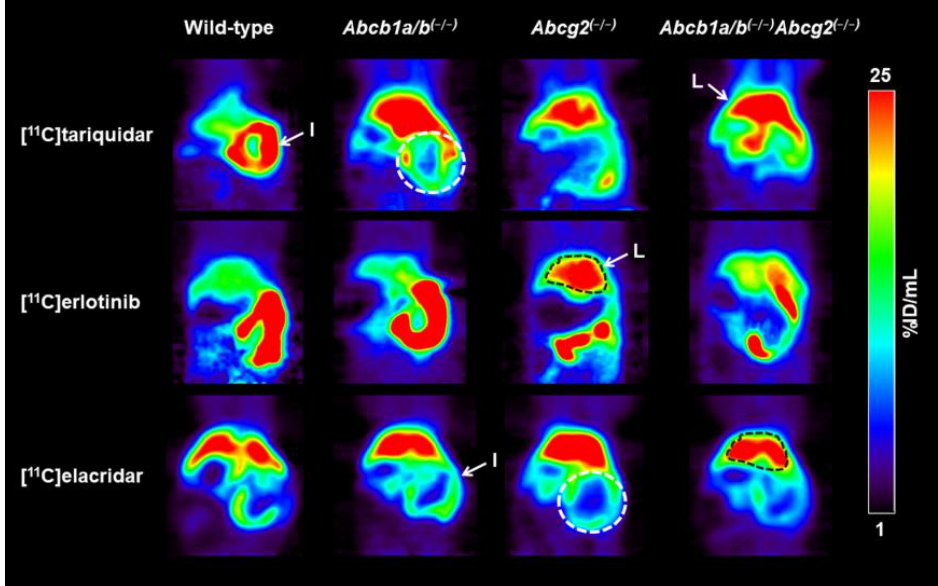
Figure 4. Coronal PET summation images (0–60 min) of the abdominal region obtained after i.v. injection of either [ 11 C]tariquidar, [ 11 C]erlotinib, or [ 11 C]elacridar in one representative wild-type, Abcb1a/b (-/-) , Abcg2 (-/-) , and Abcb1a/b (-/-) Abcg2 (-/-) mouse. Radioactivity concentration is expressed as percent of injected dose per milliliter (%ID/mL). Anatomical structures are labeled with white arrows and colored dashed-line areas (I: intestine, white; L: liver, black). The PK model (Figure 1) was used to estimate the hepatic uptake clearance (CL 1 ) Table 2. PK parameters obtained with the compartmental model describing the hepatobiliary disposition of [ 11 C]tariquidar, [ 11 C]erlotinib, and [ 11 C]elacridar in wild-type, Abcb1a/b ( − / − ) , Abcg2 ( − / − ) , and Abcb1a/b ( − / − ) Abcg2 ( − / − ) mice.